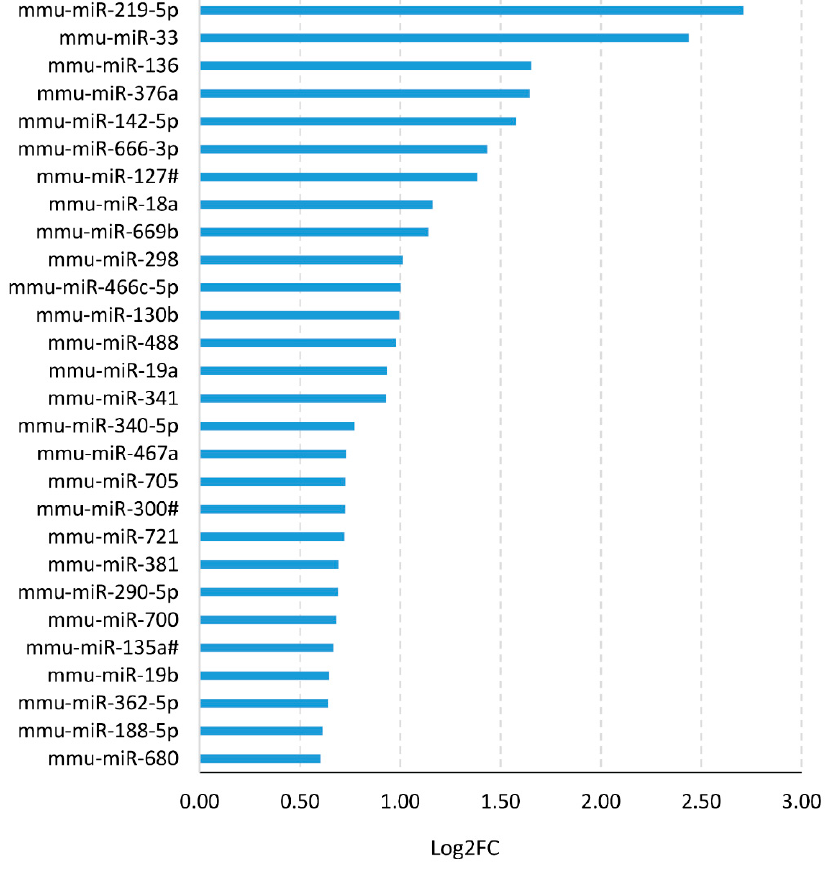
Figure 2. MicroRNA-219 (MiR-219) is up-regulated in AD11 mice. Relative Log2 expression ratio for a selected list of differentially expressed microRNAs in the hippocampus of AD11 anti-NGF mice at one month of age (AD11 vs. VH control, n = 4 vs. n = 4 samples). The list includes miR-219, which shows the largest fold change ratio. MicroRNA genes have been selected from a microarray experiment, using the following criteria: |Log2 FC| > 0.58 (FC > 1.5 in linear scale), heteroscedastic Student’s t -test p < 0.05.